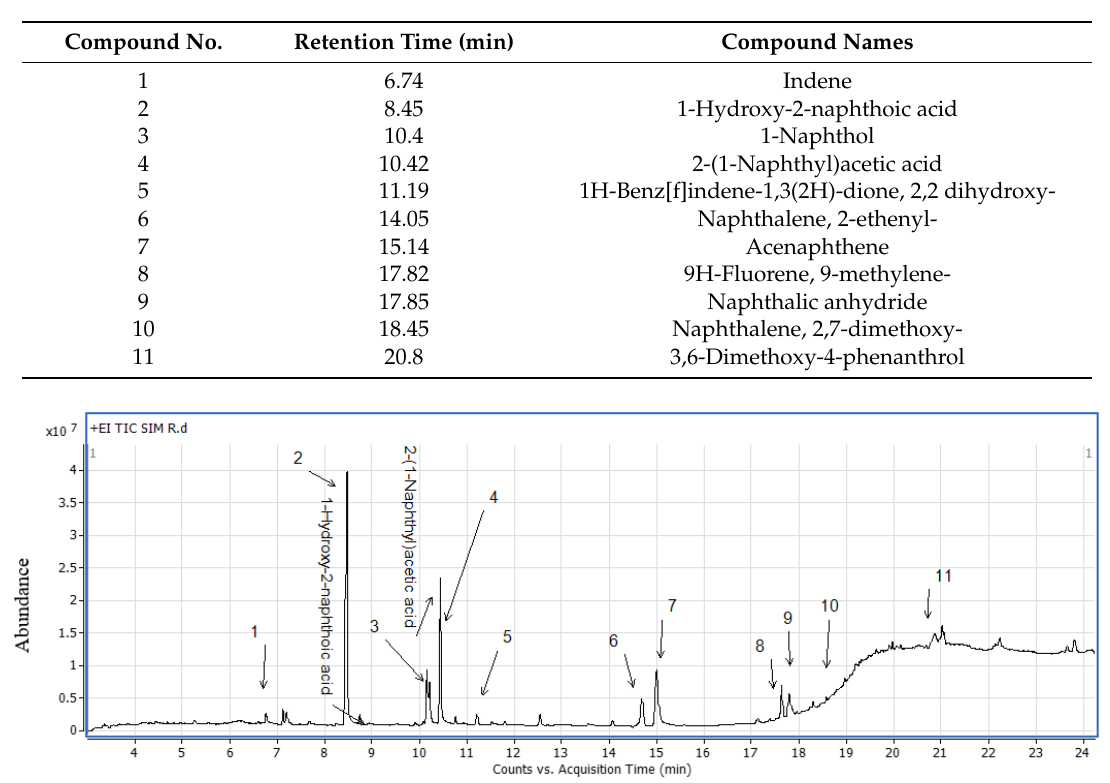
Table 4. Assignment of different derivatives of PAHs found in most of analyzed milk and dairy-based samples.